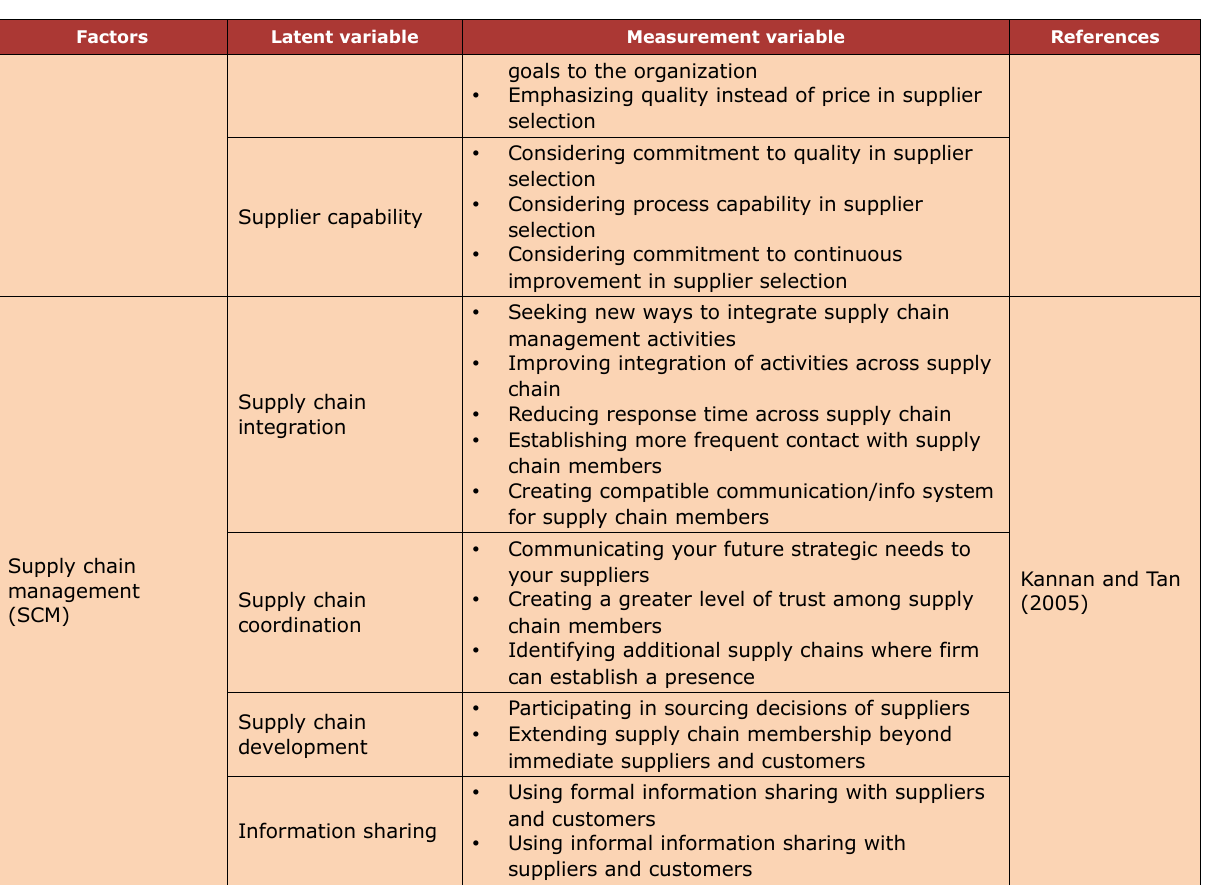
Table 1. Questionnaire of the